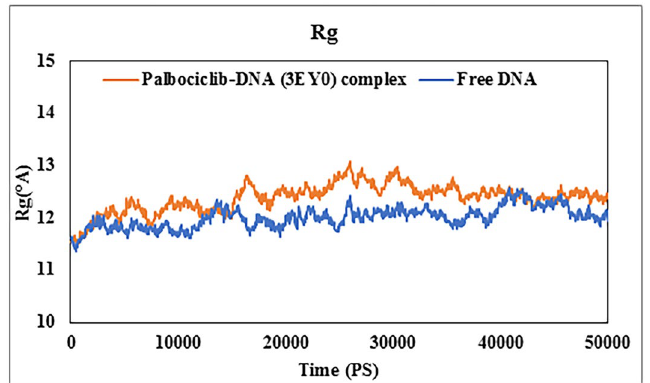
Figure 11. Radius of gyration (Rg) curves for free DNA (3EY0) (blue curve) and its complex with PLB (orange curve) after 50 ns dynamic simulation experiments.